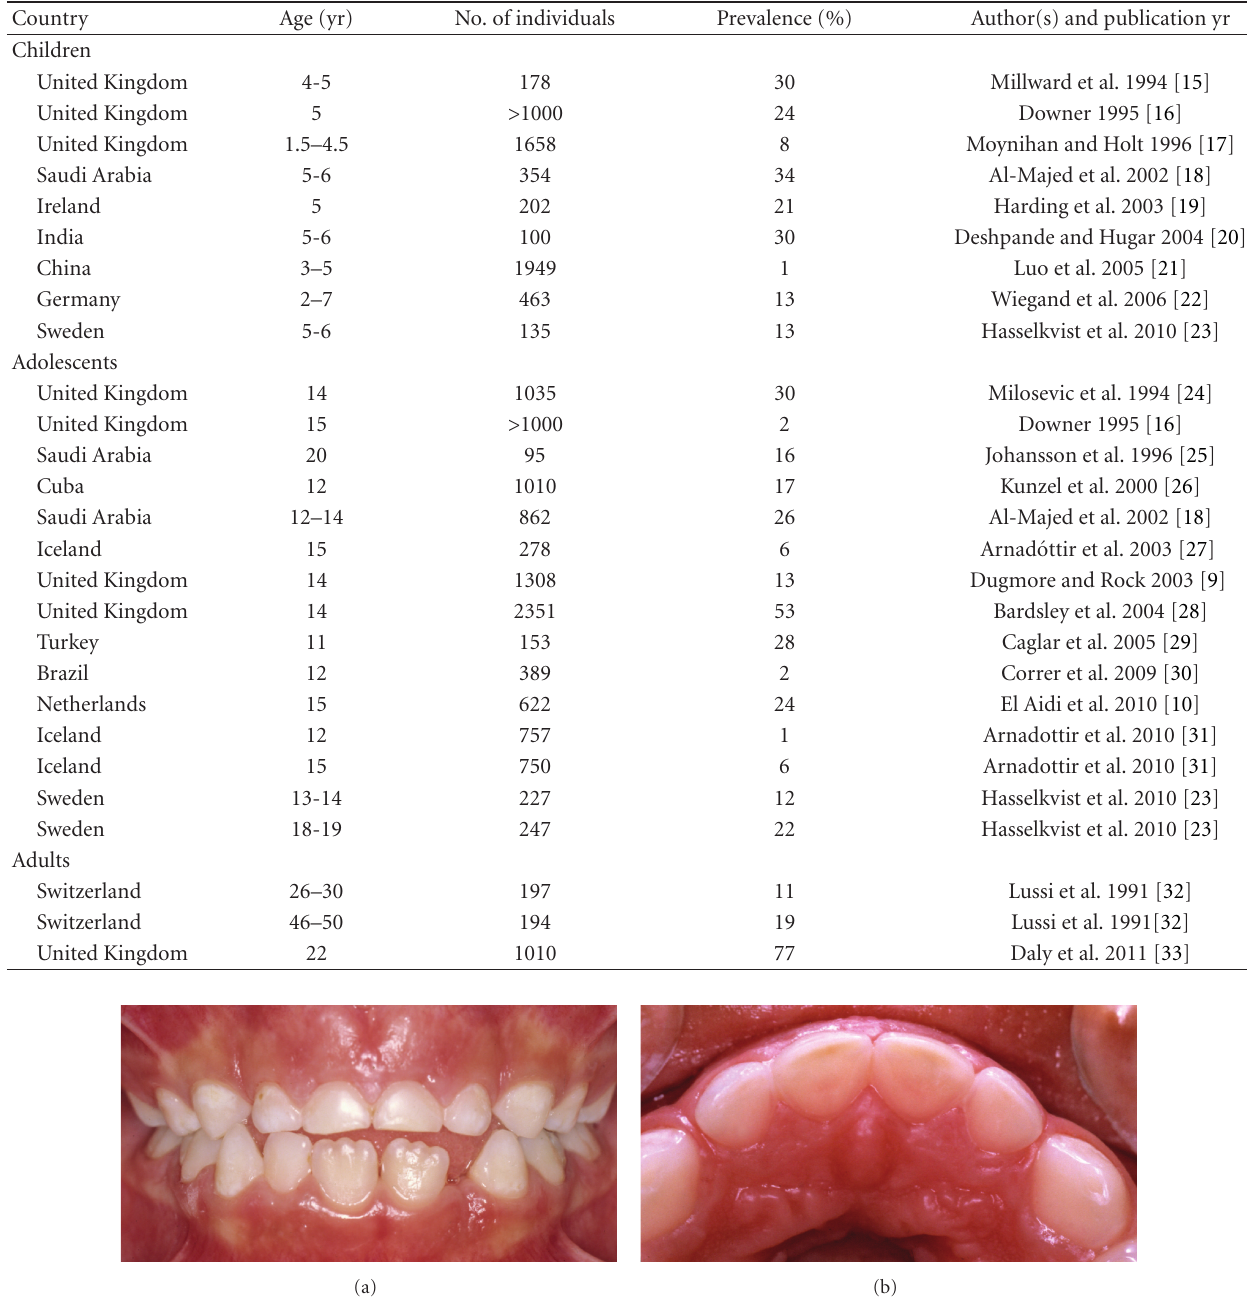
Table 1: Prevalence of dental erosion, according to studies from di ff erent countries. Prevalences, as listed, refer to erosion that reaches to the dentin or deeper.